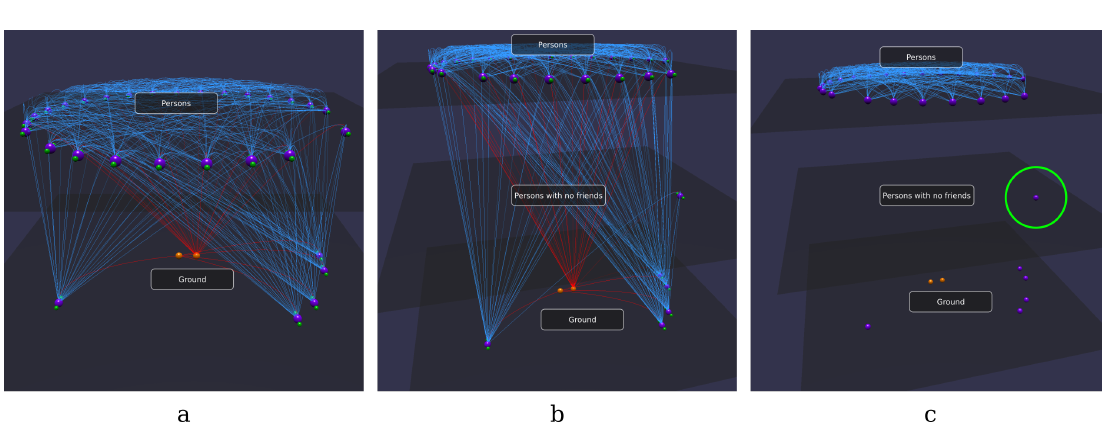
Figure 7. Use Case #1, Question 1: From the full knowledge base, a new semantic plane containing all the instances of the class foaf:Person is created ( a ). Then, all the instances involved in a friendship are moved to a second plane ( b ). All the unnecessary edges are hidden to notice one instance of the class foaf:Person with no incoming or outgoing foaf:knows edges ( c